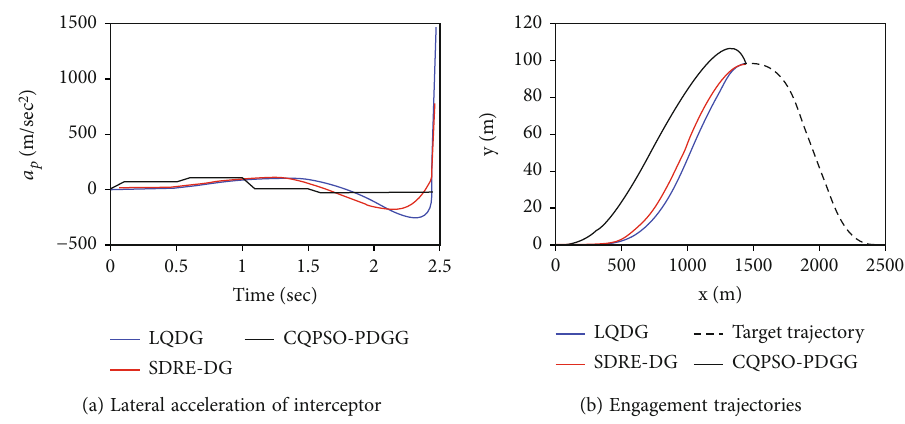
Figure 10: Comparison with SDRE-DG and LQDG in the presence of sinusoidal target maneuver.